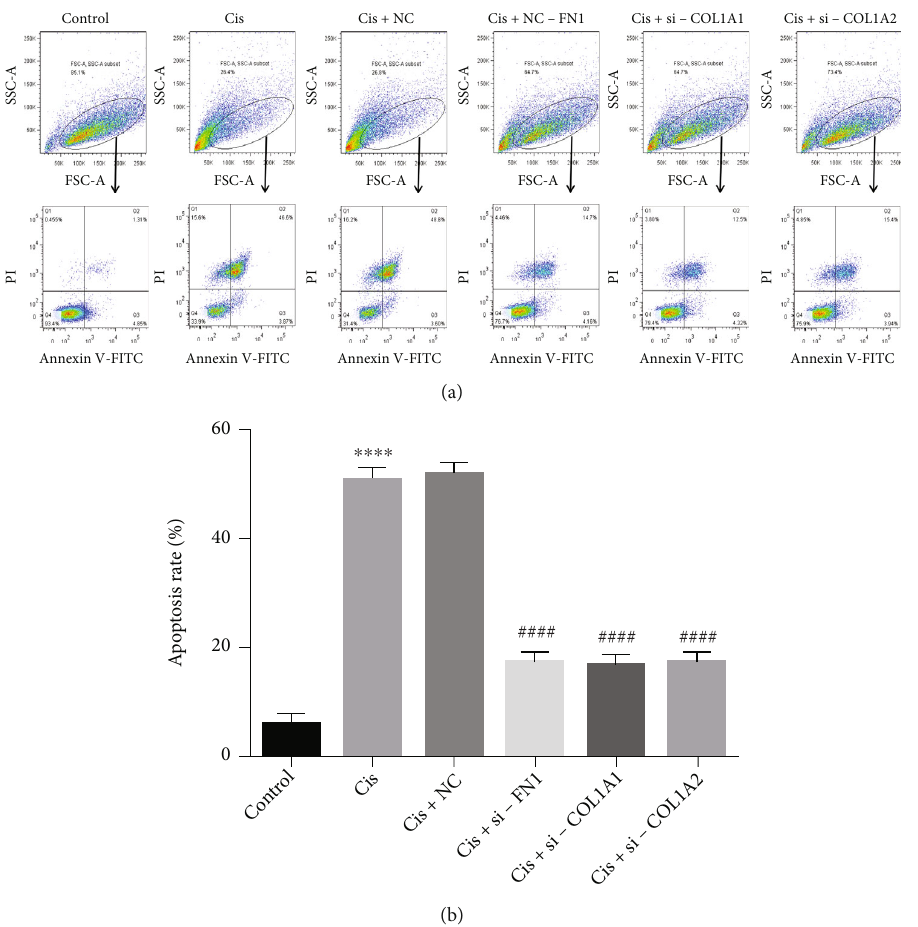
Figure 8: Flow cytometric analysis was used to detect the e ff ects of FN1, COL1A2, or COL1A1 knockdown combined with cisplatin and cisplatin alone on cell apoptosis of U2OS cells. ∗∗∗ ∗ p < 0 : 001 compared with the control group, #### p < 0 : 001 compared with the Cis +NC group. Table 1: The clinical characteristics of patients with osteosarcoma and Ewing ’ s